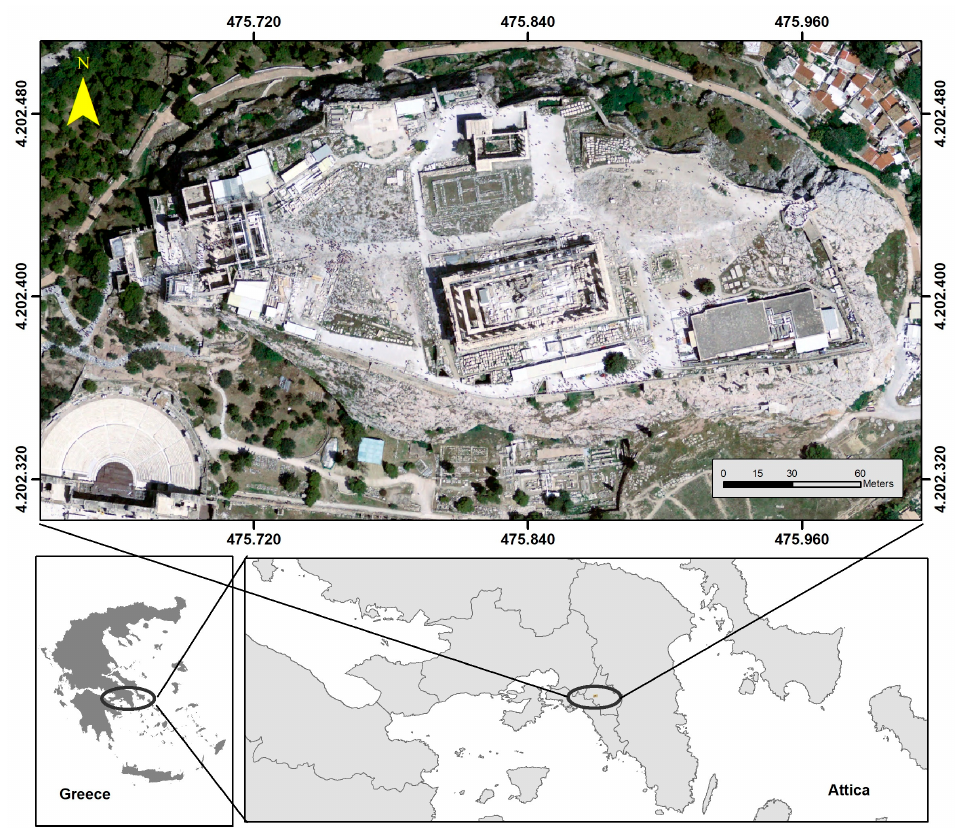
Figure 1. The study area and its location in different